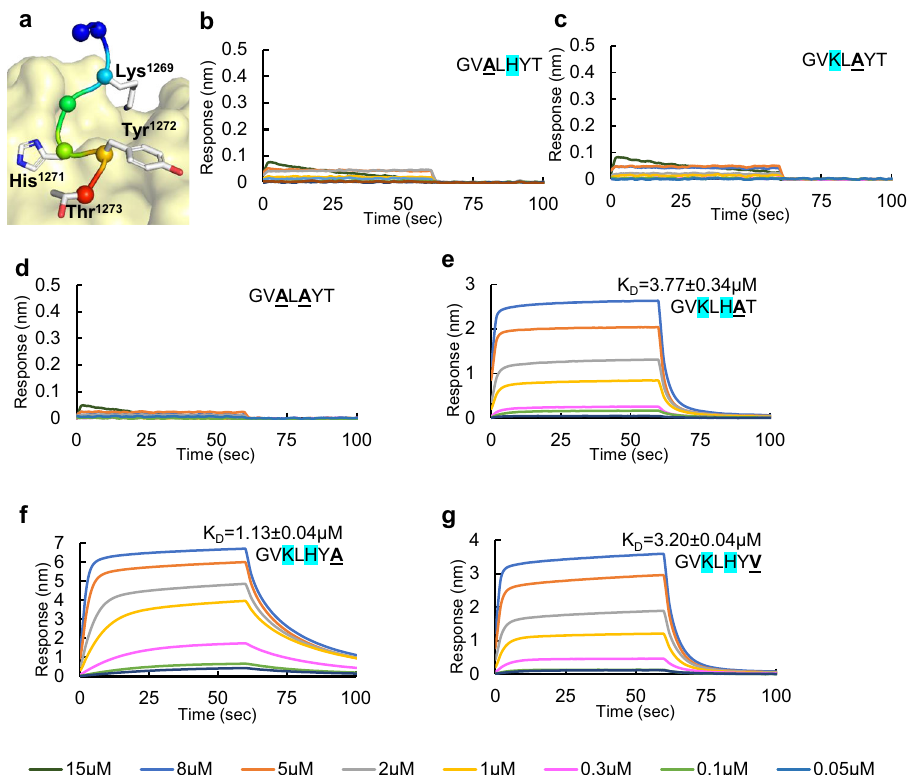
Fig. 3 Structure-guided mutagenesis of spike hepta-peptide and binding analysis with α COPI-WD40 domain. a In silico model of the spike hepta- peptide complexed with α COPI-WD40 domain (yellow surface). The hepta-peptide is shown as a ribbon in rainbow colors from N (blue) to C (red) terminus. The C α -atoms in the hepta-peptide are shown as spheres. The side chains of residues that interact with α COPI-WD40 are shown as a stick. b – g BLI analyses of α COPI-WD40 binding to spike hepta-peptide mutants. The color code of BLI traces is given at the bottom of the fi gure. One representative experiment of three is shown. Color code for concentrations is given at the bottom of the fi gure. The mutation in the spike hepta-peptide sequence is highlighted in bold and is underlined. The equilibrium K D is provided with each sensorgram for comparison. Mutagenesis of, ( b ) Lys 1269 , ( c ) His 1271 , or ( d ) both abolishes binding to α COPI-WD40. e In contrast, Tyr 1272 → Ala mutation only weakens binding to α COPI-WD40. The middle panel shows weak binding of α COPI-WD40 domain with a hepta-peptide wherein Lys 1269 has been mutated to Ala. f Mutagenesis of Thr 1273 to Ala in the spike hepta-peptide leads to moderately enhanced binding to α COPI-WD40 whereas mutagenesis to Val 1273 weakens binding ( g ). Interestingly, a prior analysis implicated β -branched residues at the Table 2 In silico mutagenesis of extended dibasic motif in penultimate position in the PEDV spike sequence in modulating SARS-CoV-2 spike. interactions with COPI-WD40 domains 28 .